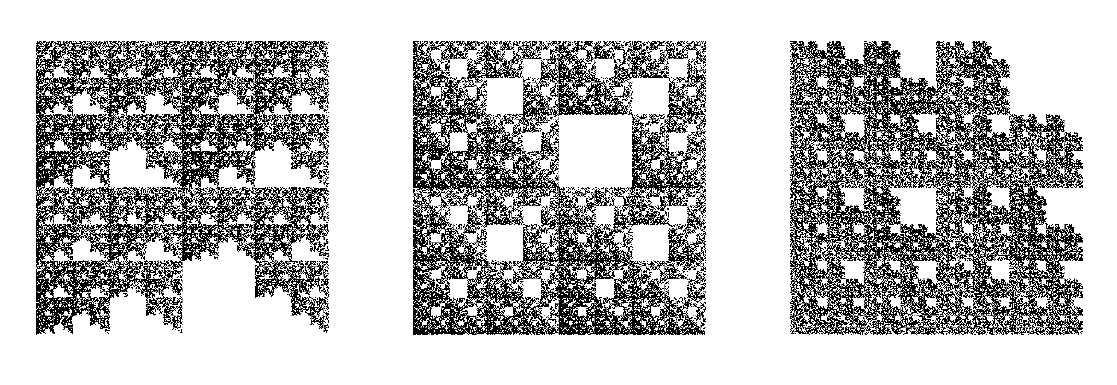
Figure 8. CGR in the “ACGT” square, with A = ( 0,0 ) , T = ( 1/2,0 ) , G = ( 1/2,1/2 ) , C = ( 0,1/2 ) played with 8 × 10 4 points. Left part: “AT” moves are forbidden (model TR12). Middle part: “AG” moves are forbidden (model TR13). Right part: “GG” moves are forbidden (model TR33).